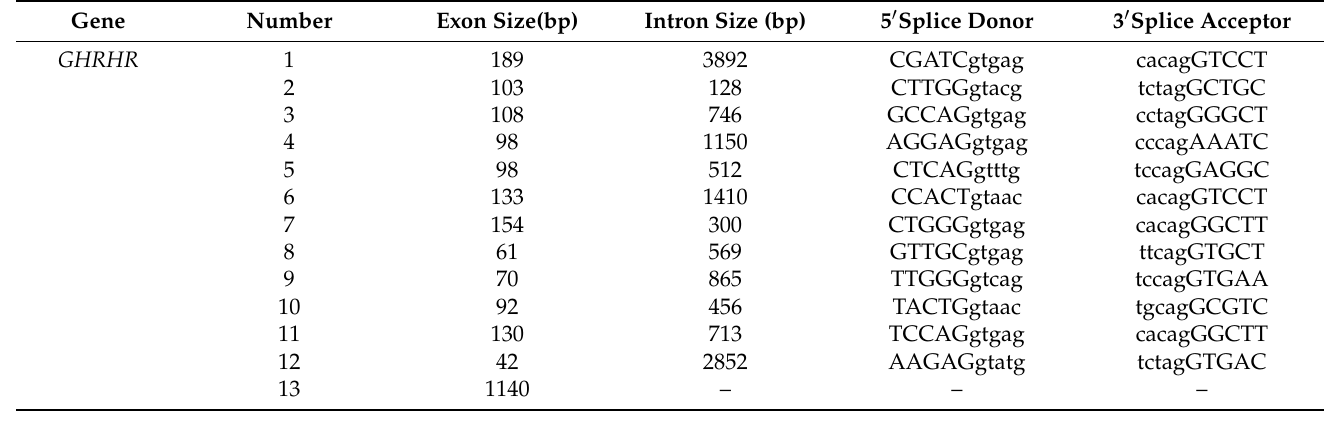
Table 2. The 5′-donor and 3′-acceptor splice sites in GHRHR. Table 2. The 5 (cid:48) -donor and 3 (cid:48) -acceptor splice sites in GHRHR .